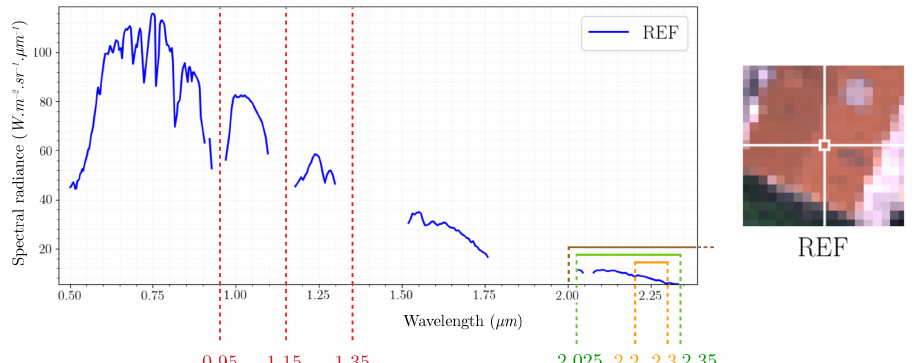
Figure 4. Spectrum of a pixel extracted from the reference (REF) image from the “Toulon” dataset (Section 3.2): identification of the tested spectral intervals in the SWIR II domain (broad band in brown, Sentinel-2 in green, and Sentinel-3 in orange), and three possible limits separating the Gain-2P application domains (in red). The represented spectral bands are the ones whose atmospheric trans- mission is superior to